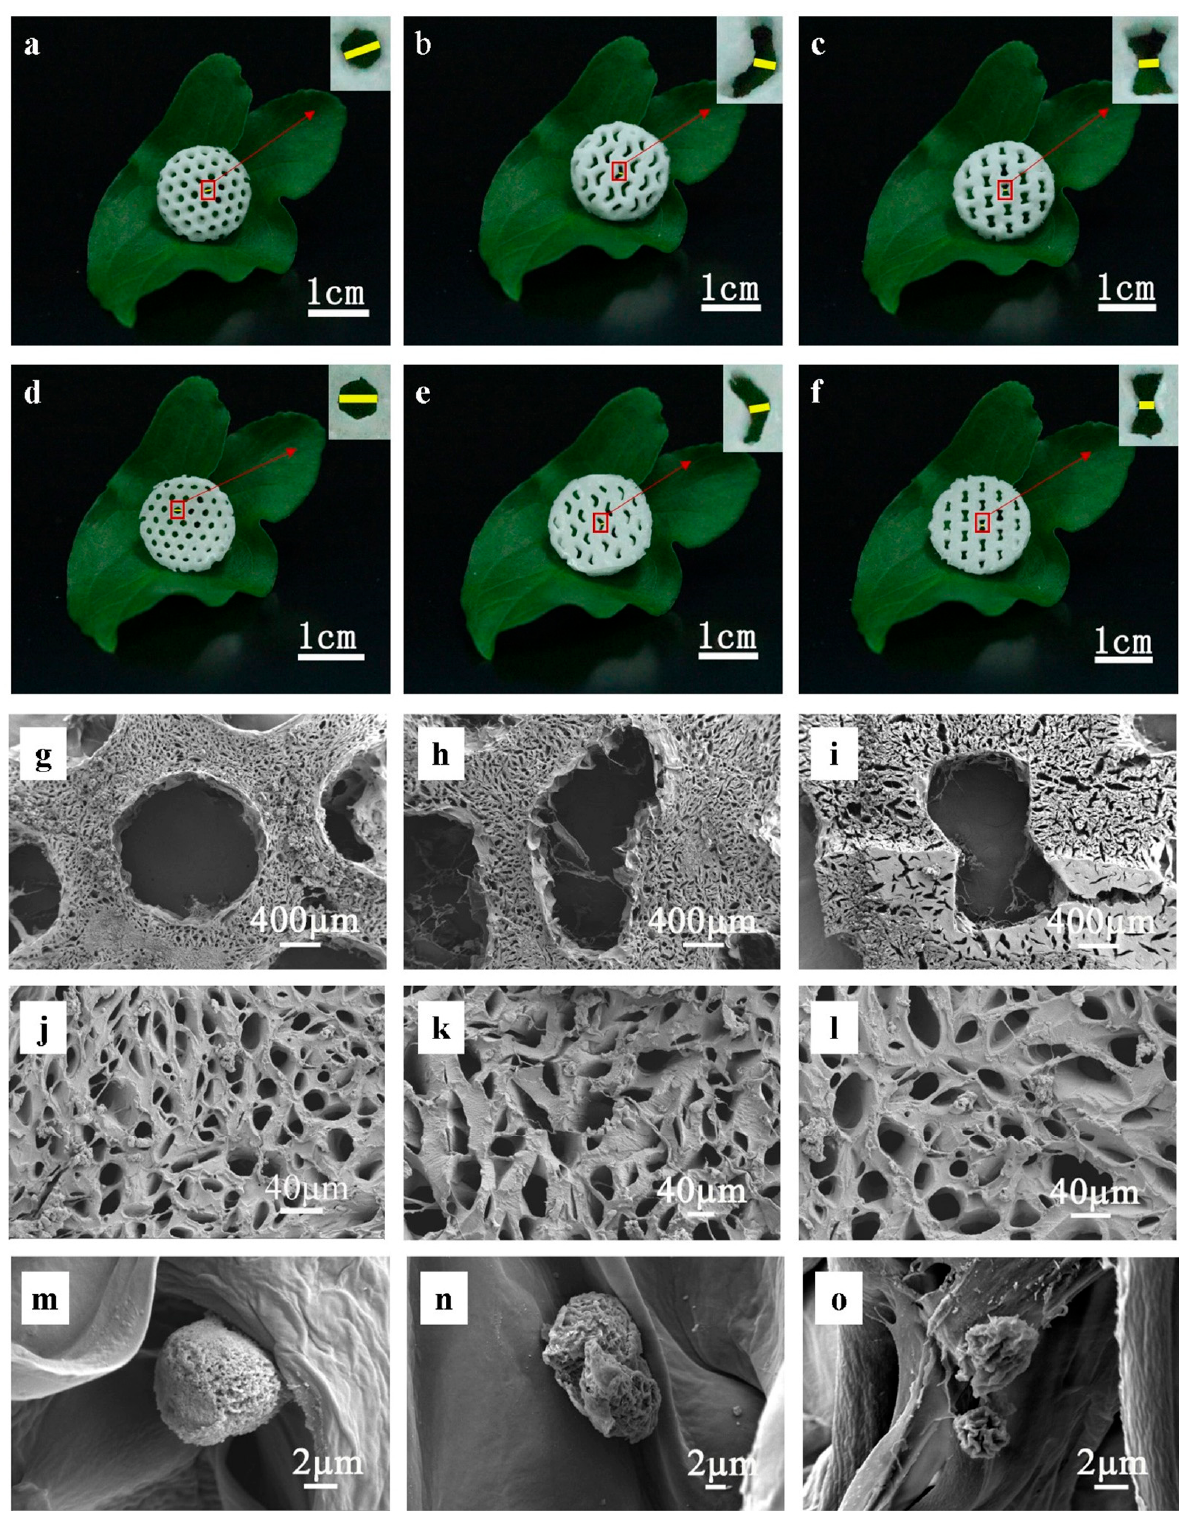
Figure 3. ( a – f ) Digital photographs of the exposure surface and backlit surface of CNF/PEGDA aerogels. ( g – l ) SEM images of CNF/PEGDA scaffolds with different Poisson’s ratios. ( m – o ) SEM images of cell adhesion after inoculation on CNF/PEGDA scaffolds. Left to right: ( a , d , g , l , m ) PPR; ( b , e , h , k , n ) ZPR; ( c , f , i , l , o ) NPR. The illustration shows a magnified view of local